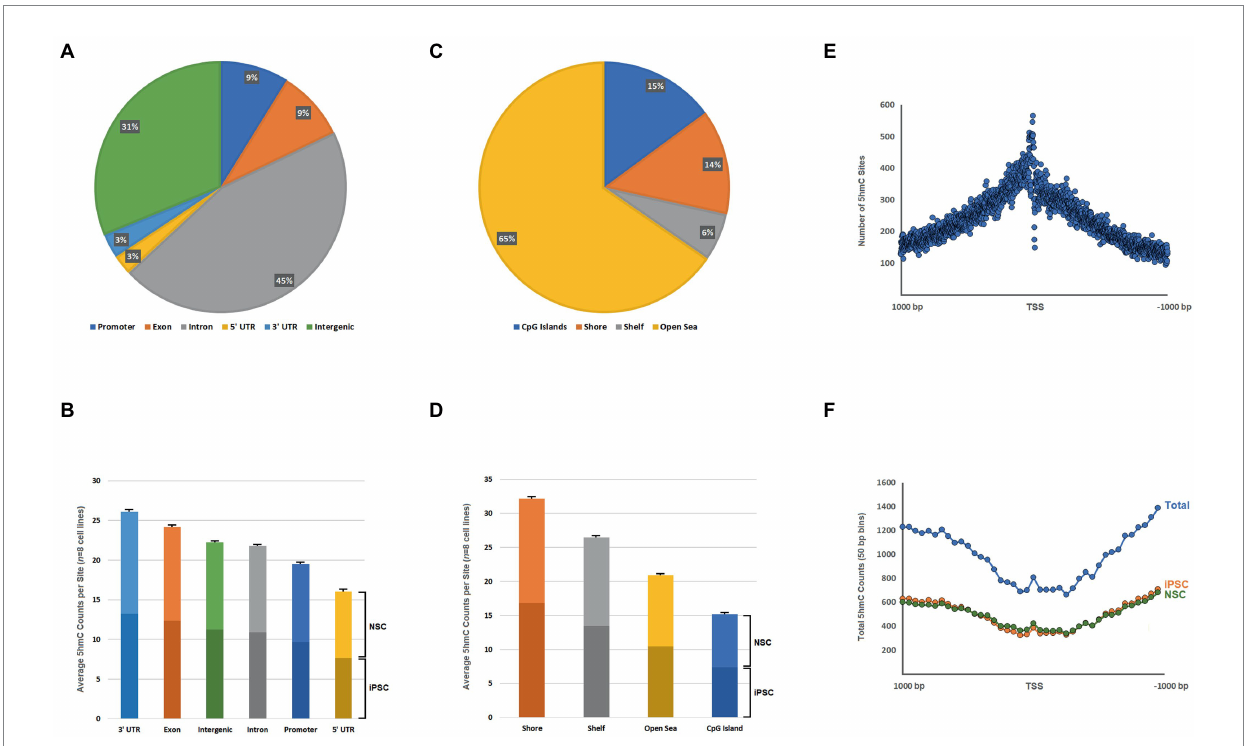
FIGURE 1 (A) Pie chart of the proportions of 5hmC sites ( n = 1,979,923) mapped to the following genome features: exon, intron, 5 ′ UTR, 3 ′ UTR, promoter region (1-kb upstream of TSS), and intergenic; (B) Bar chart of mean normalized 5hmC counts per site for all eight cell lines (with SEM bars) according to different genome categories (iPSC-and NSC-specific means indicated by differential bar shades); (C) Pie chart of the proportions of 5hmC sites mapped to the following CpG-related genomic landscapes: CpG island (CGI), CpG shore (2 kb region adjacent CGIs), CpG shelf (2–4 kb from CGI boundaries), and open sea; (D) Bar chart of mean normalized 5hmC counts per site for all eight cell lines (with SEM bars) according to different CpG landscape types (iPSC-and NSC-specific means indicated by differential bar shades); (E) Distribution of the total number of observed 5hmC sites according to distance from the TSS (±1,000 bp) for all annotated genes; and (F) Distribution of total normalized 5hmC counts according to distance from the TSS (±1,000 bp; 50-bp bins) for all annotated genes.